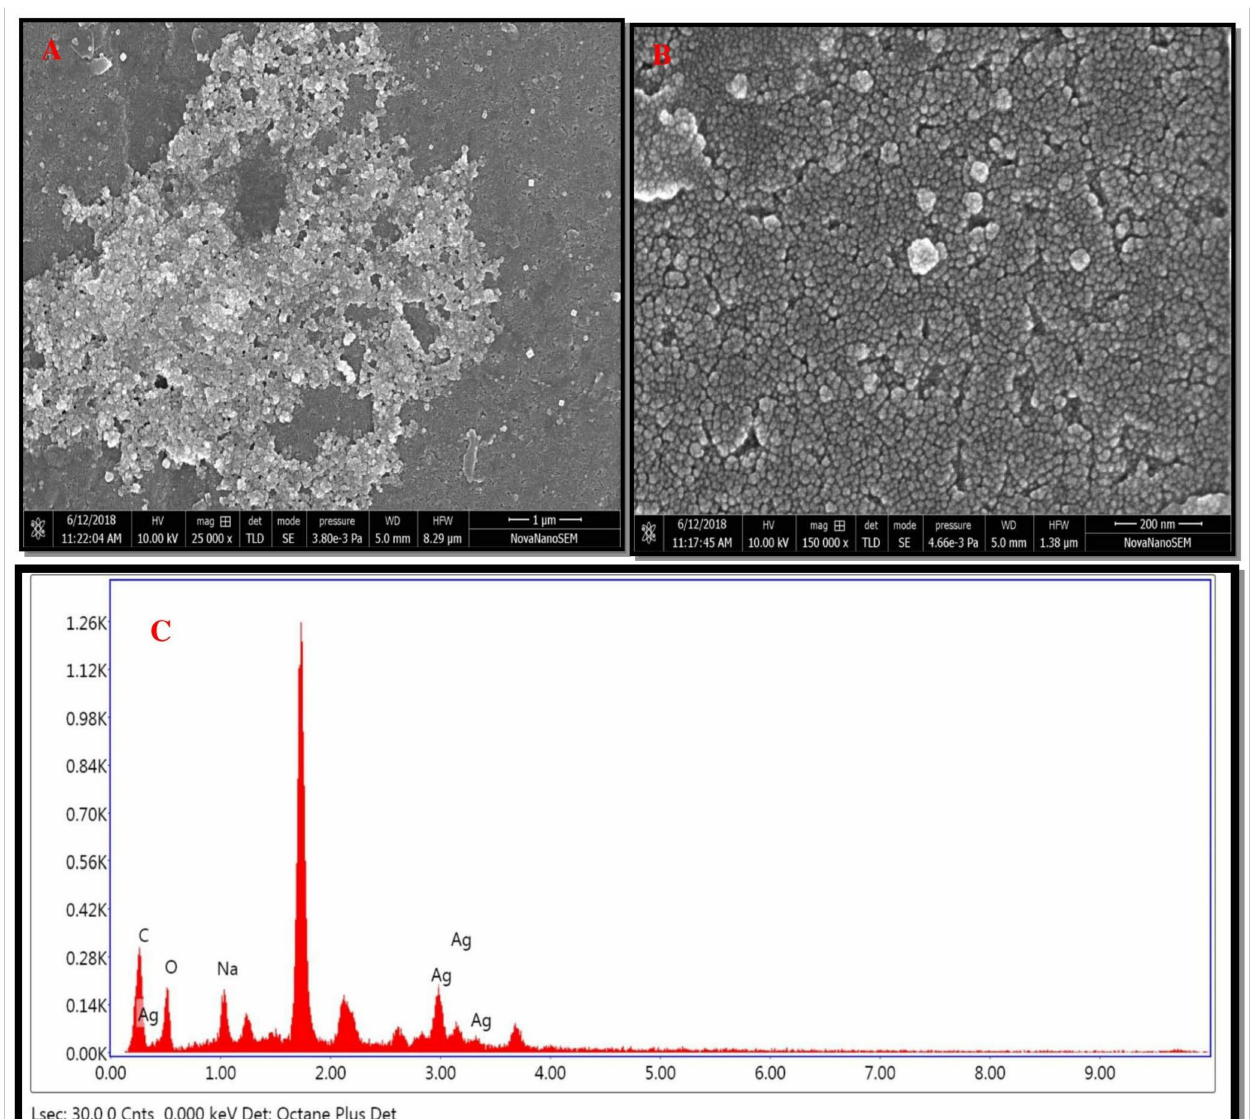
Figure 6. HR-SEM images of green AgNPs. ( A ) HR-SEM images of green AgNPs at 1 µ m, ( B ) HR-SEM images of green AgNPs at 200 nm, ( C ) and EDX spectrum of green synthesized